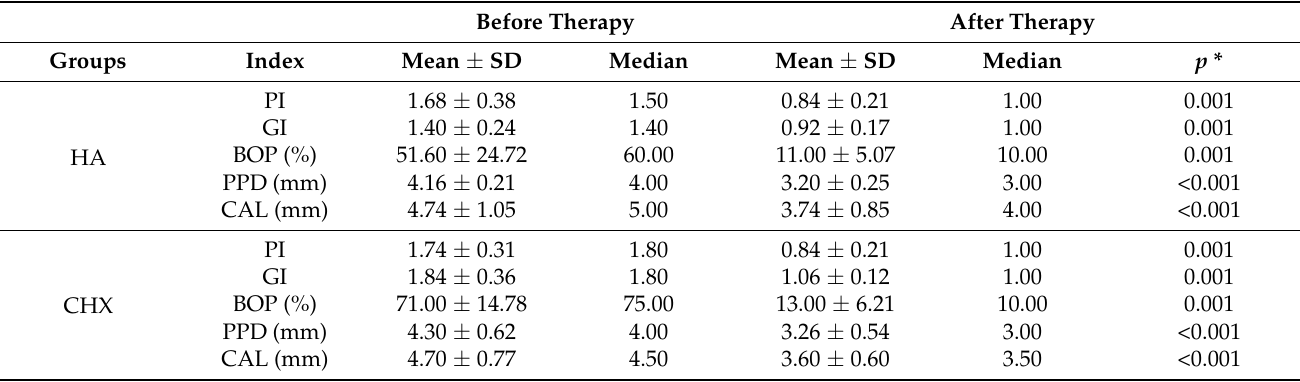
Table 1. Clinical periodontal parameters before and after therapy for the three studied groups. Before